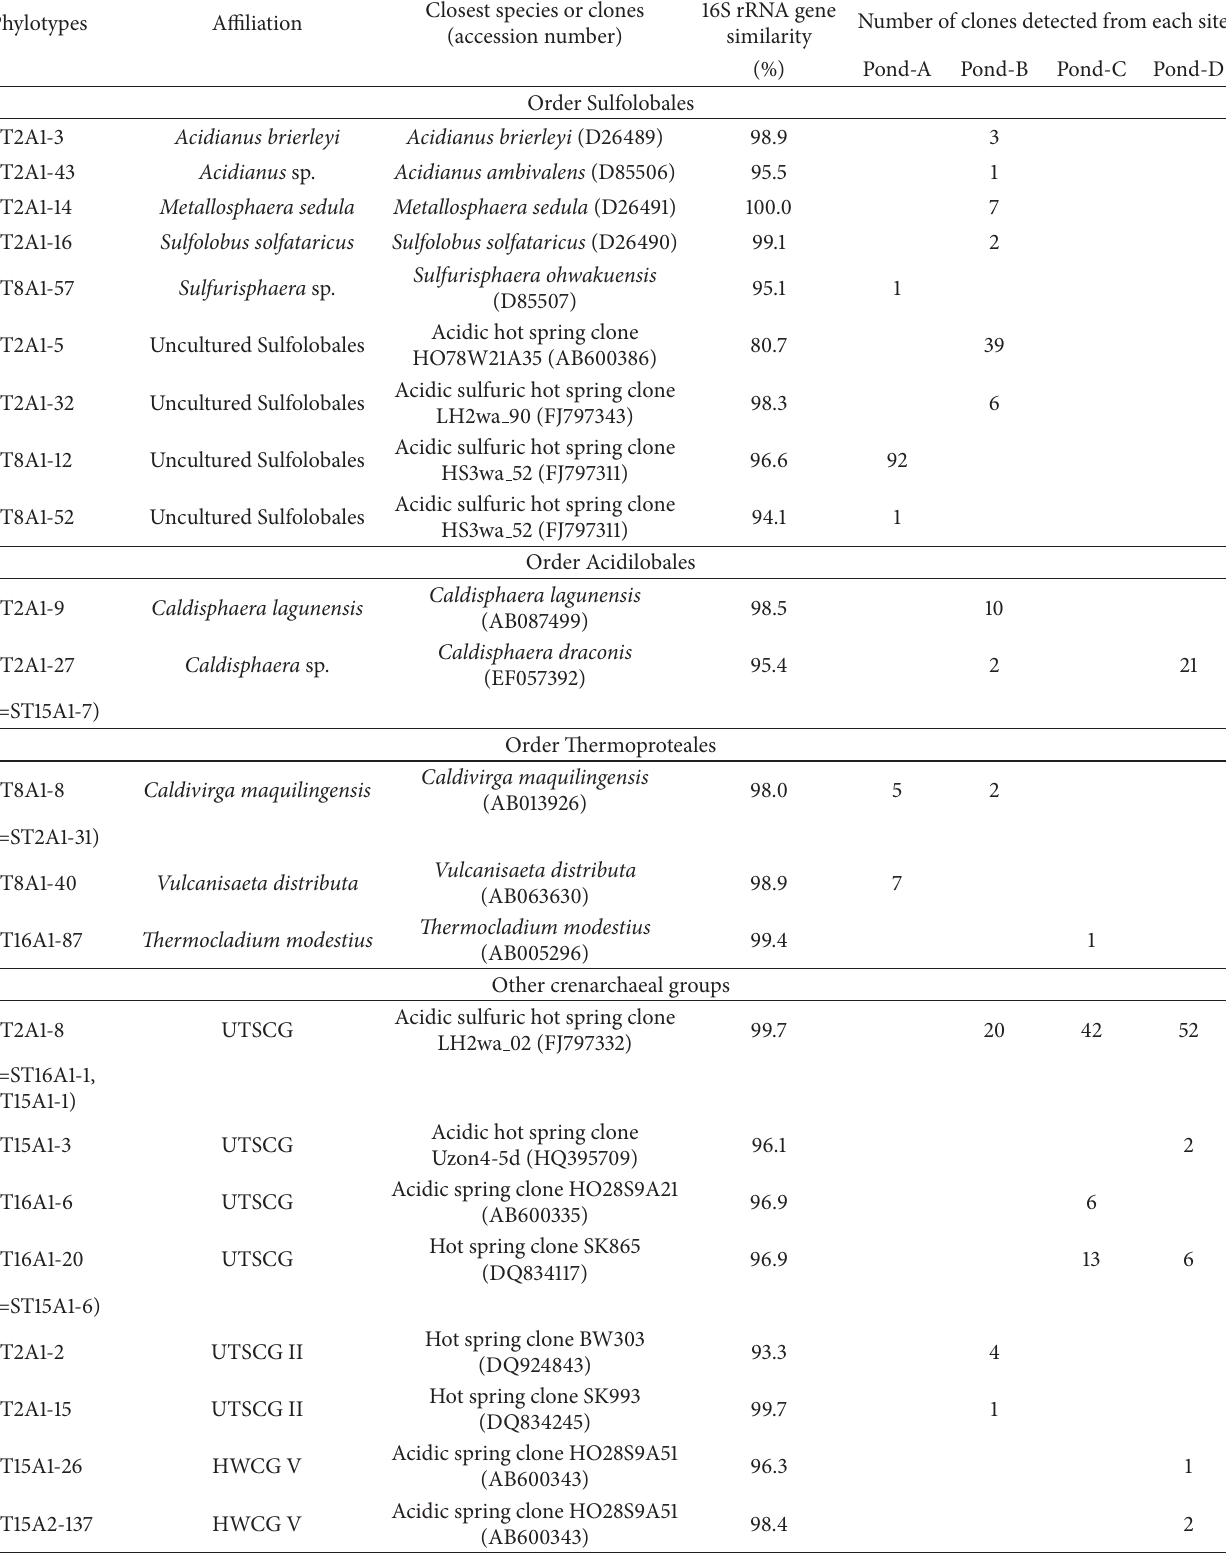
Table 2: Affiliation and closest published species or clones of 26